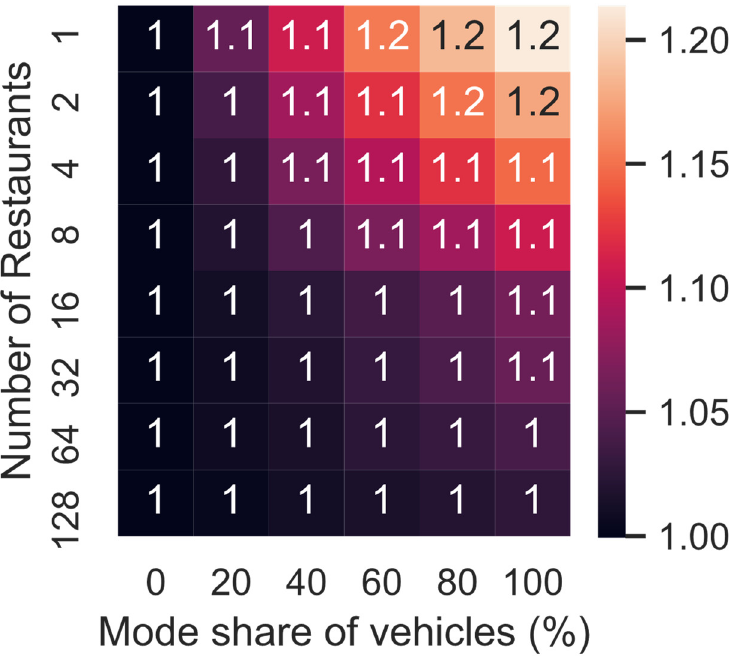
Figure 8. Increase in the CO 2 emissions per km for varying mode share and number of restaurants.